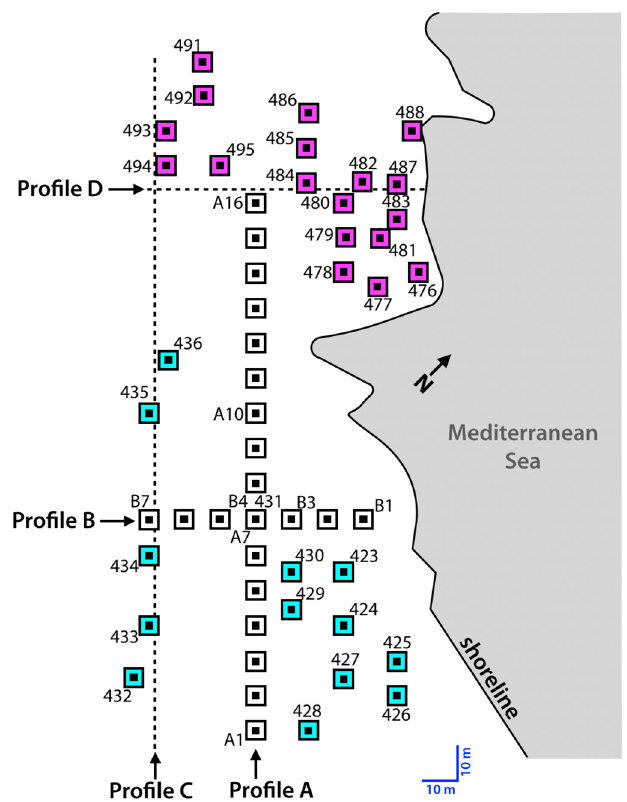
Figure 3. Location of TDEM soundings and four 2D transects are shown. A symbol denotes position of each sounding and differences in colors refer to different measurement dates. TDEM soundings deployed during July 2018, June 2019, and July 2019 are indicated by black-and-white, black-and-cyan and black-and-purple symbols, respectively.